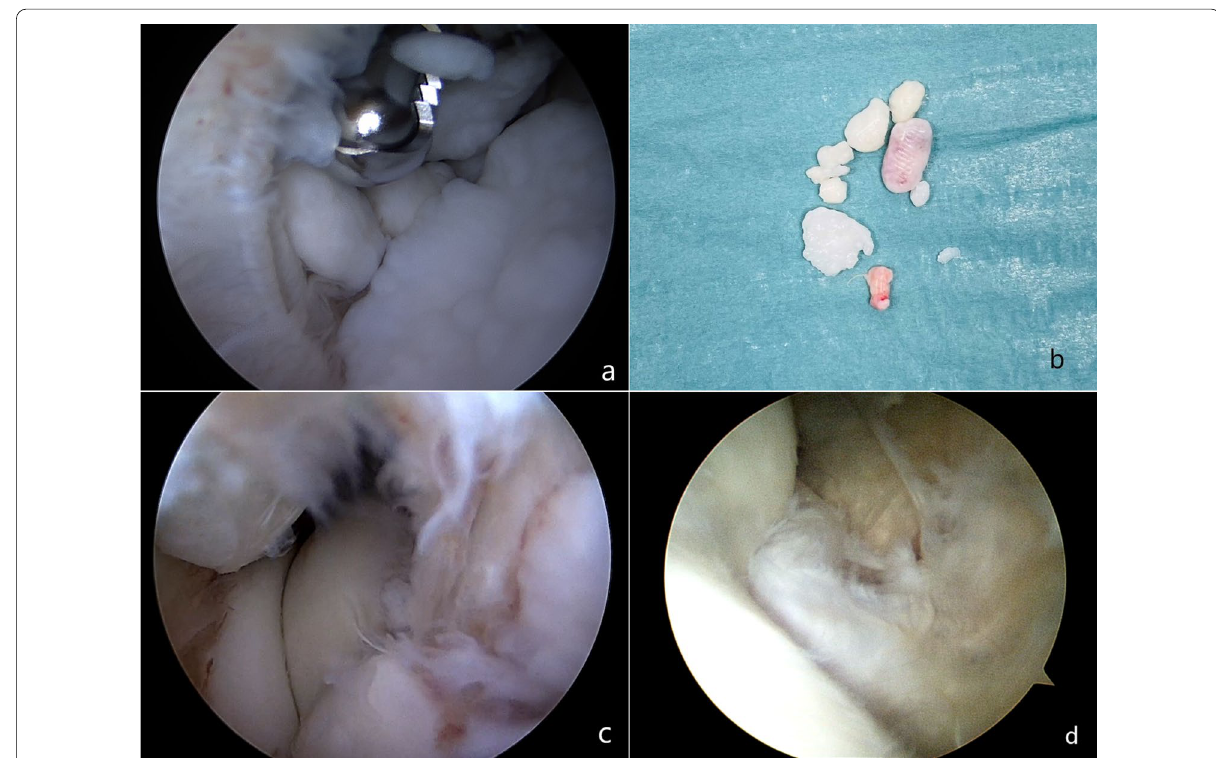
Fig. 1 Intraoperative arthroscopic pathological findings. Intraoperative arthroscopic pathological findings. a loose bodies identified during arthroscopic exploration of the joint cavity. b Some loose bodies removed from the anterior and the posterior compartments during the procedure. c , d extensive arthrofibrosis involving the radiocapitellar joint and the medial joint compartment (humeral